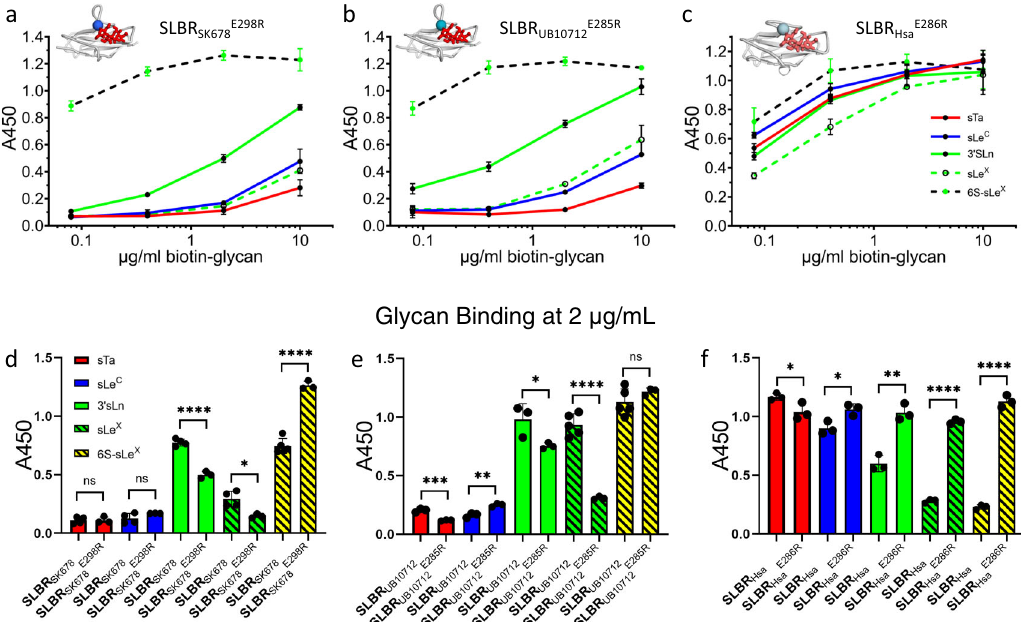
Fig. 7 Binding selectivity of CD loop variants in SLBR SK678 , SLBR UB10713 and SLBR Hsa . Dose response curves of biotin-glycan binding to immobilized variant GST-SLBRs (500 nM). a GST-SLBR SK678 E298R , b GST-SLBR UB10712 E285R , c GST-SLBR Hsa E2866 . The respective SLBRs are shown in gray cartoon in the top left corner of each panel with the site of mutation represented as a colored sphere. sTa, shown in red sticks, was placed over the binding site by superimposing sTa bound-SLBR Hsa . Measurements were performed using 500 nM of immobilized GST-SLBR and the indicated concentrations of each ligand are shown as the mean ± SD. d – f Binding of each sugar at 2 µ g/mL to each mutant was statistically compared to binding of the same sugar to the SLBR WT with the values presented in a – c using a two-tailed parametric t test. Black circles represent individual data points and bars represent the mean ± SD ( n = 3 independent experiments performed on protein from a single preparation). Statistical signi fi cance is indicated by: ns, p > 0.05; *, p < 0.05; **, p < 0.01; ***, p < 0.001; ****, p < 0.0001). In panel d , the p values from left to right are 0.94, 0.15, <0.0001, 0.013, and <0.0001. In panel e , the p values from left to right are 0.0007, 0.0034, 0.046, <0.0001, and 0.24. In panel f , the p values from left to right are 0.047, 0.019, 0.0016, <0.0001, and <0.0001. Source data are provided as a Source Data fi